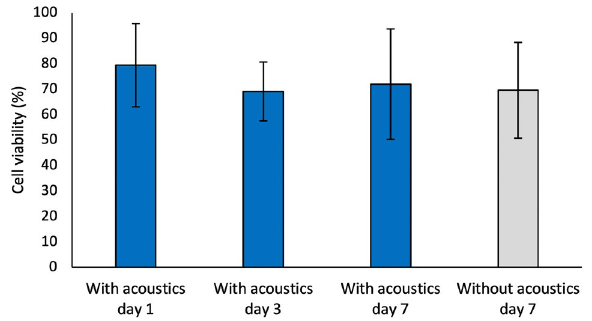
Figure 6. The viability of acoustically focused astrocytes in hydrogel droplets after 1, 3 and 7 days of culture. As a control group, astrocytes encapsulated in hydrogel droplets without acoustic focusing is shown after 7 days of culture.